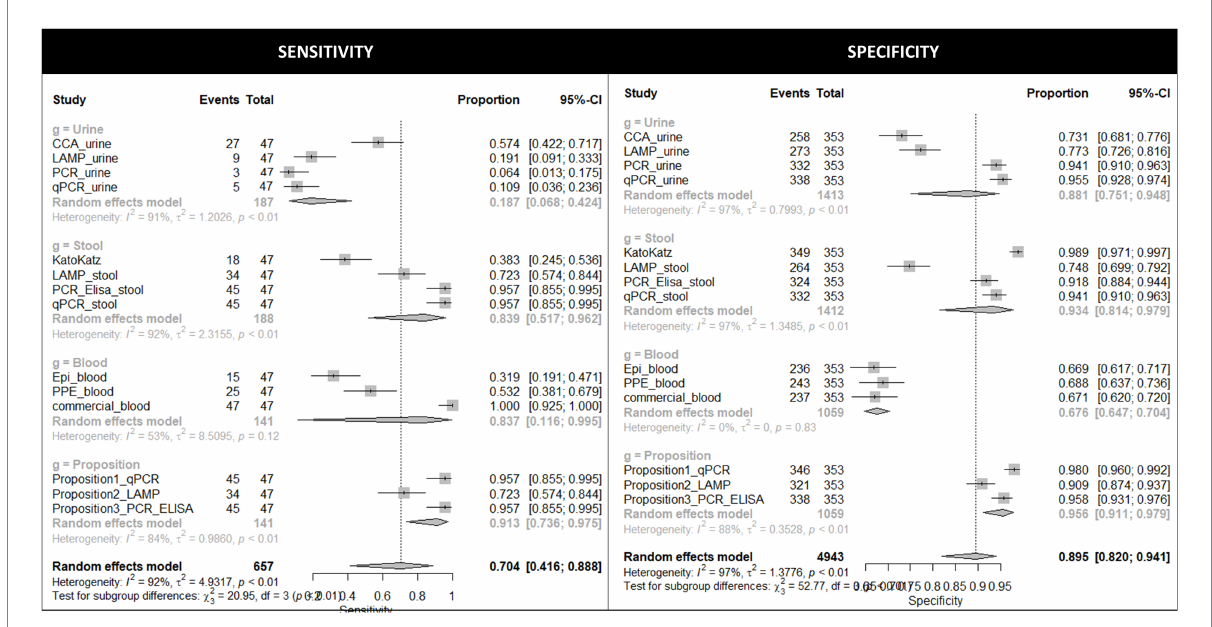
FIGURE 4 Forest plots illustrating the estimated sensitivity and specificity of the 11 individual diagnostic tests evaluated, and the three two-step diagnostic approaches proposed, in this